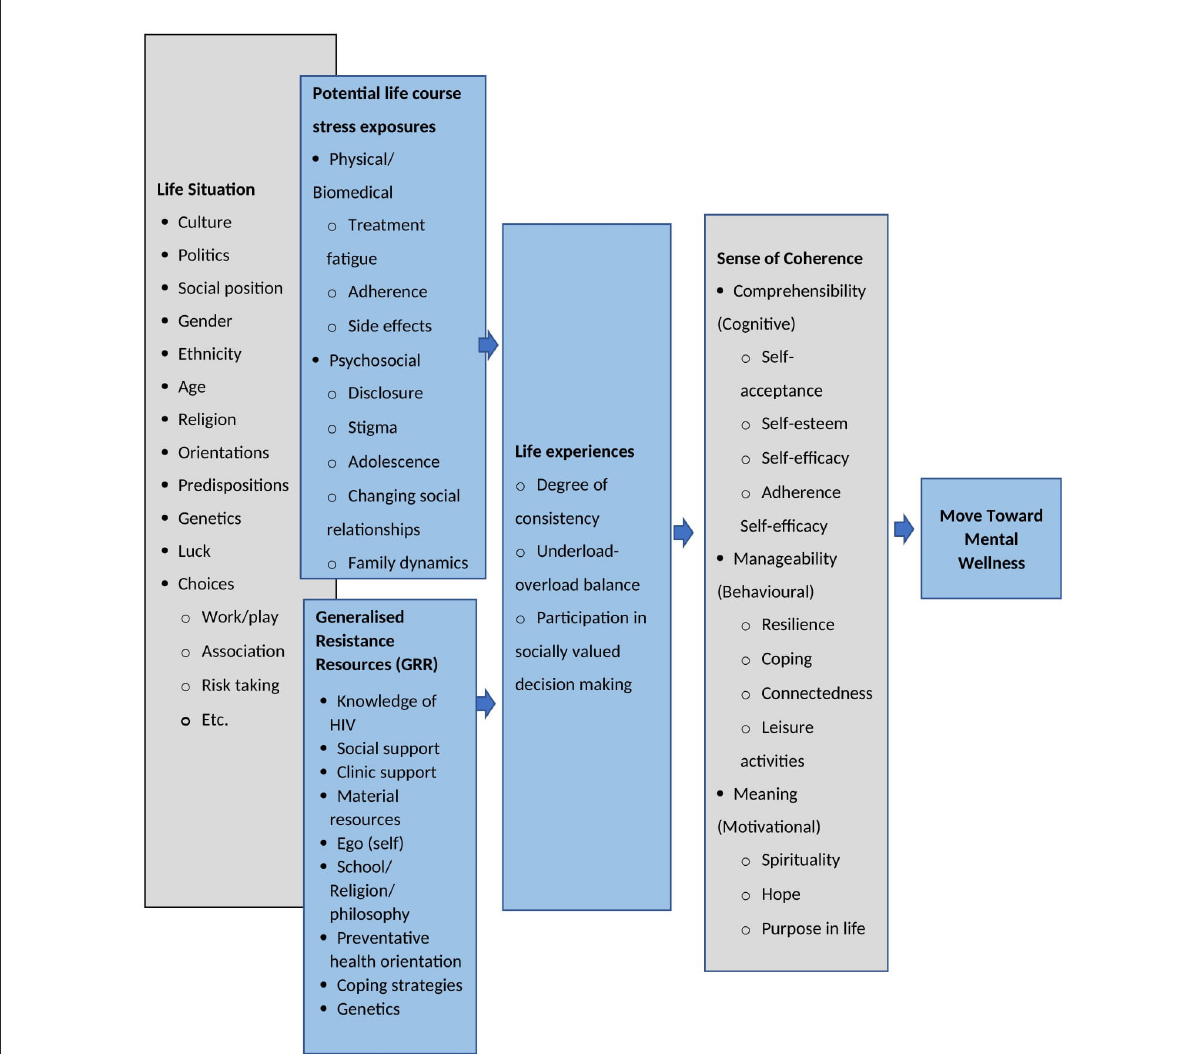
FIGURE3 Salutogenic model of mental wellness for adolescents living with HIV adapted from Antonovsky, 1987 (Mittelmark et al., 2015) and Benz et al.